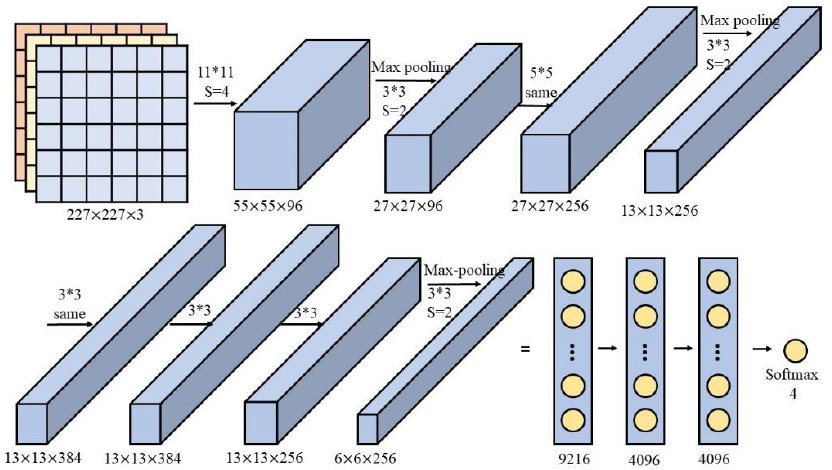
Figure 2. Modified AlexNet structure.